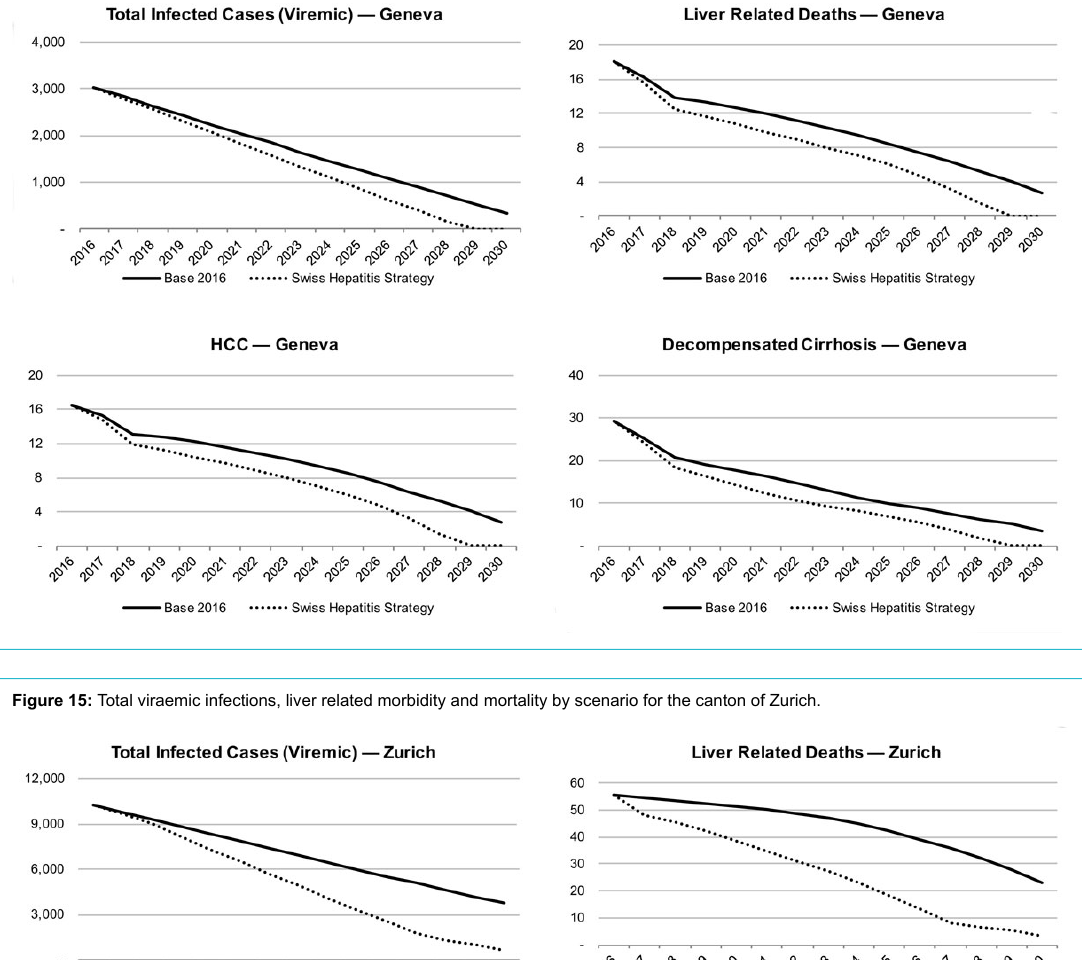
Figure 14: Total viraemic infections, liver related morbidity and mortality by scenario for the canton of Geneva.